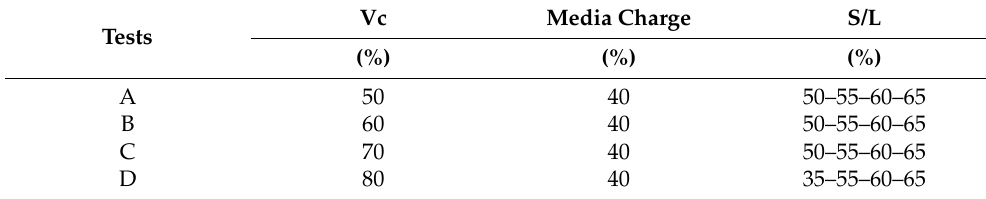
Table 3. Experimental design of the rod mill experiments for modeling purposes. Vc is the critical rotational speed of the mill, the solid feed is 3 kg/min, rod diameter 30 mm, and lifter height 23 mm.